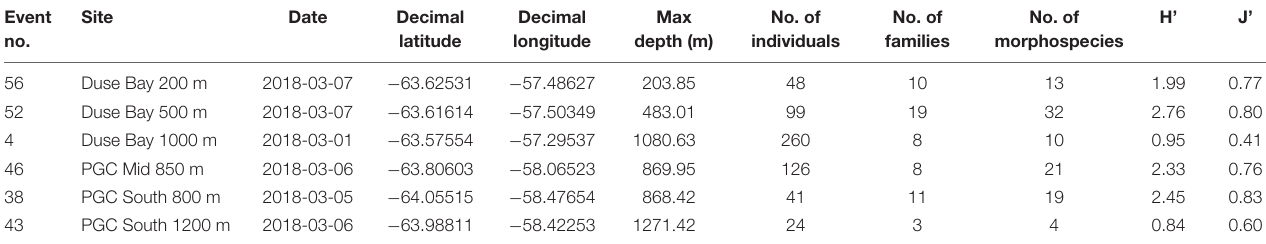
TABLE 1 | Details of Agassiz Trawl stations within the Prince Gustav Channel sampled during the expedition JR17003a. Event